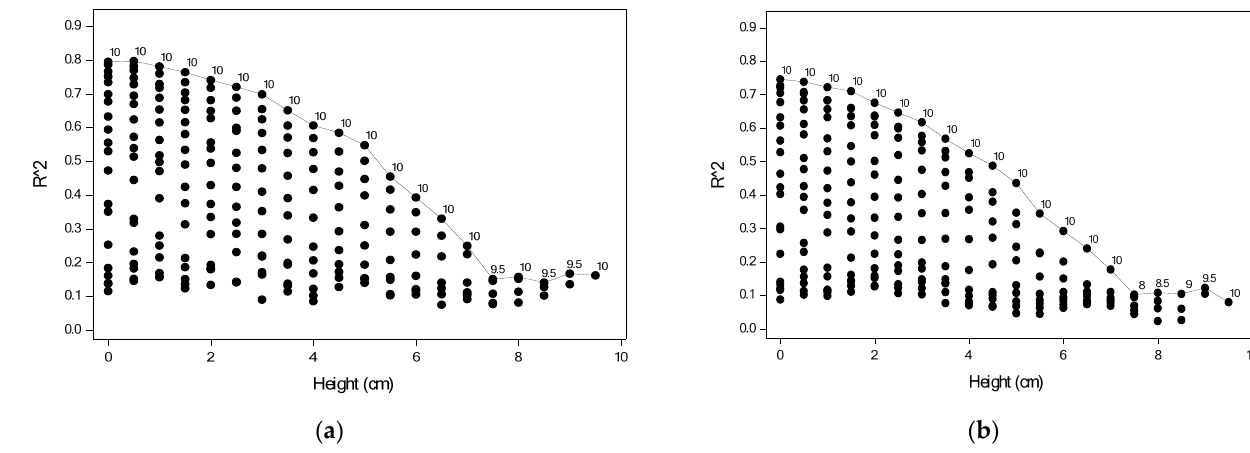
Figure 9. R 2 values based on plantar pressures for 210 models for Module IIIa: ( a ) right foot; ( b ) left foot.